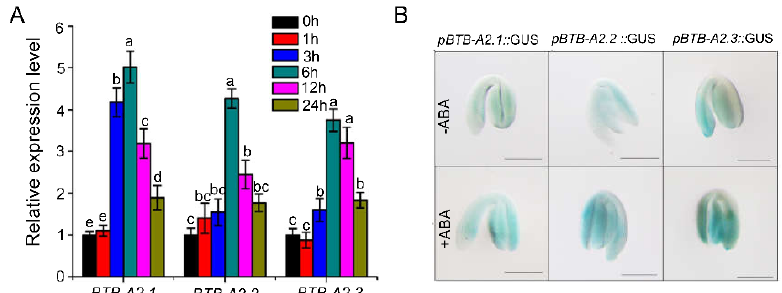
Figure 3. Expression levels of BTB-A2.1 , BTB-A2.2 , and BTB-A2.3 under ABA induction. ( A ) Transcription expression levels of BTB-A2.1 , BTB-A2.2 , and BTB-A2.3 under ABA induction.